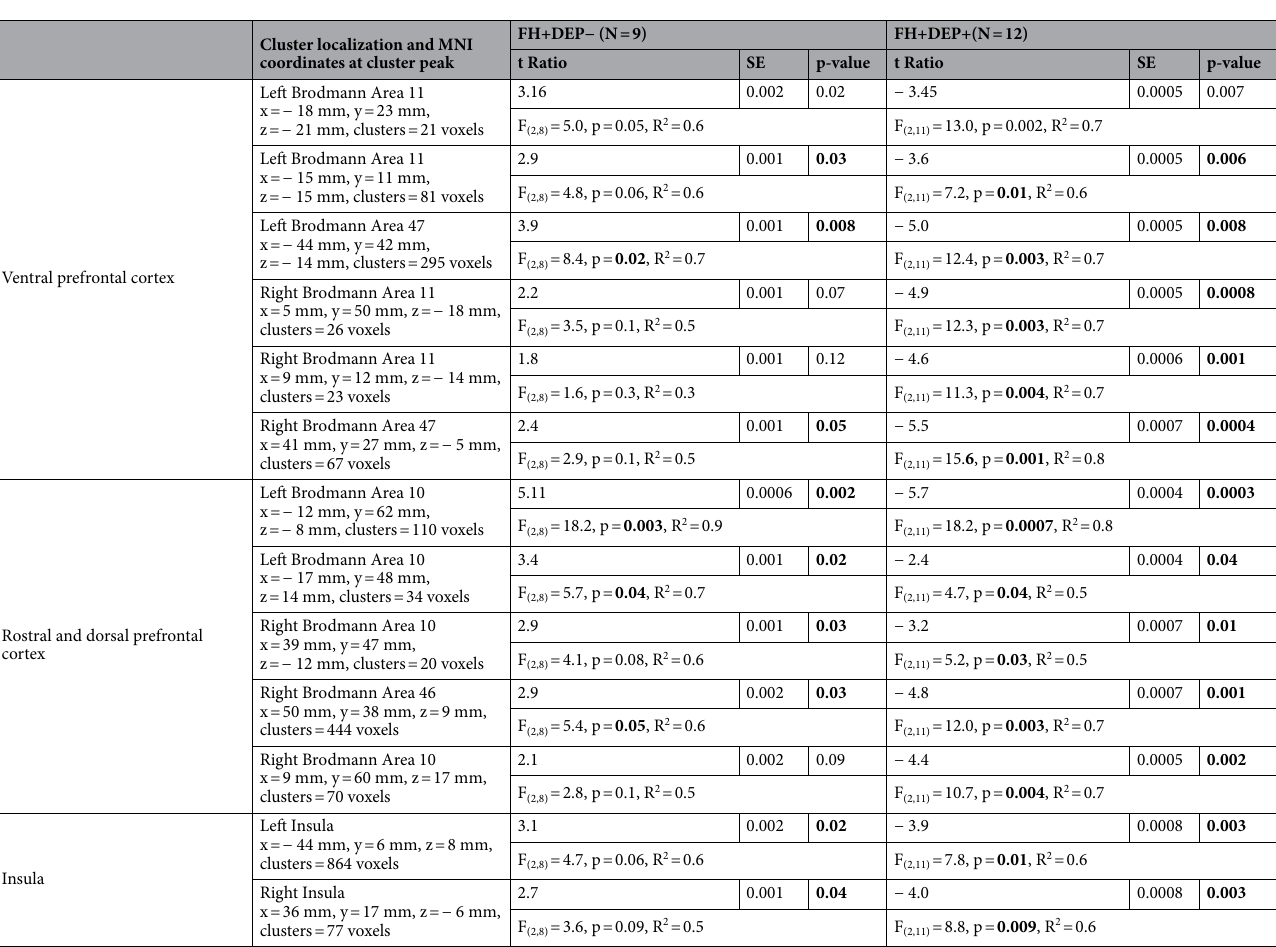
Table 4. Areas of gray matter volume showing a significant FH+ subgroup (FH+DEP− vs. FH+DEP+) by Childhood Trauma Questionnaire total score interaction. Brodmann Area and Montreal Neurological Institute space coordinates for clusters showing a significant FH+ subgroup by Childhood Trauma Questionnaire (CTQ) total score interaction. Using extracted gray matter volume (GMV) from these clusters, relations between CTQ total score and extracted GMV were modeled stratified by bipolar disorder family history positive (FH+) subgroups [FH+ individuals without a history of unipolar depression (FH+DEP−); FH+ individuals with a history of unipolar depression (FH+DEP+)] while covarying biological sex. Results are reported for the overall model for each cluster, and the GMV factor within each model for each